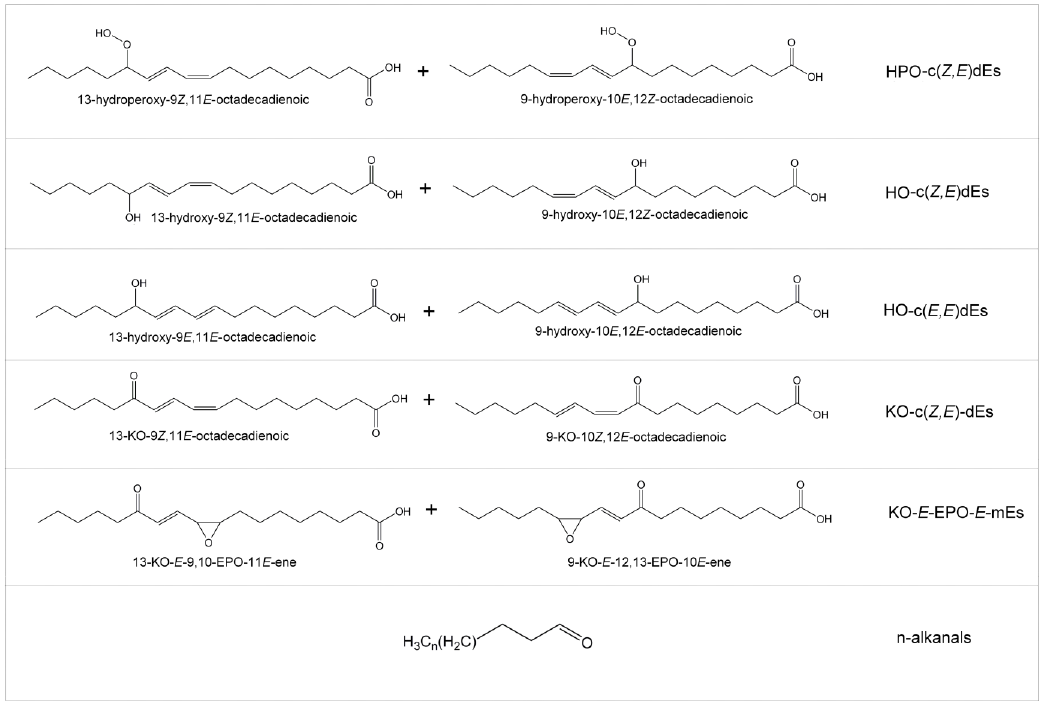
Figure 3. Chemical structures of some potential oxidation compounds present in the digestates of the corn oil samples enriched in alpha